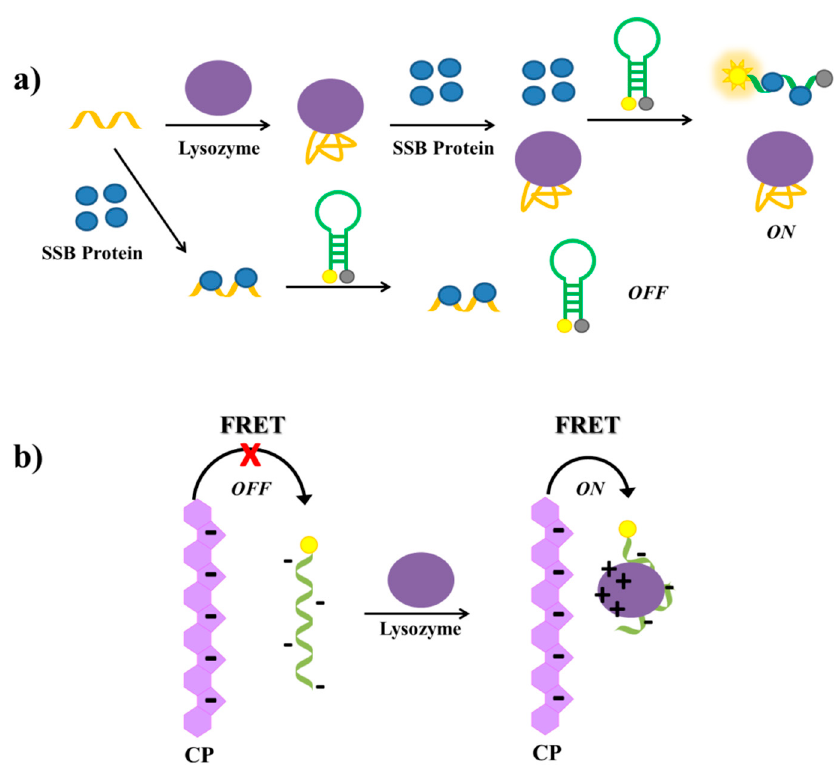
Figure 18. Schematic representation of lysozyme detection strategies based on: ( a ) competitive binding involving the lysozyme aptamer, a molecular beacon and single-stranded binding (SSB) protein [141]; ( b ) FRET between an anionic conjugated polymer (CP) and the labelled lysozyme aptamer [145].